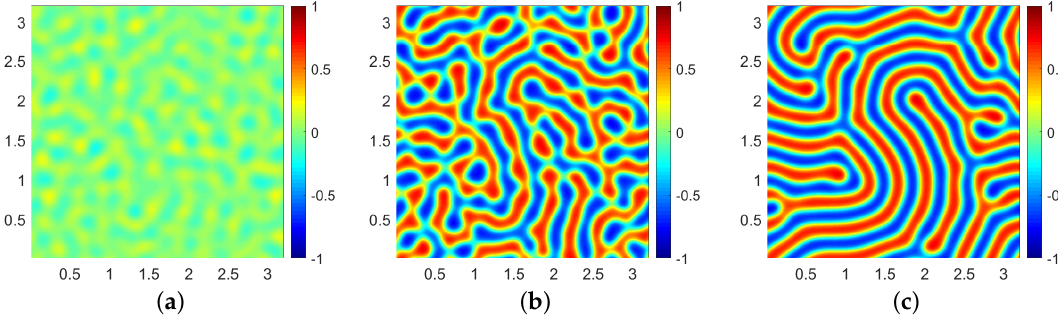
Figure 13. ( a – c ) are the snapshots of numerical solutions of the nonlocal CH model (4) with the initial condition (44) at t = 20 ∆ t , 60 ∆ t , and 10000 ∆ t , respectively. For colored figures, see the manuscript of web